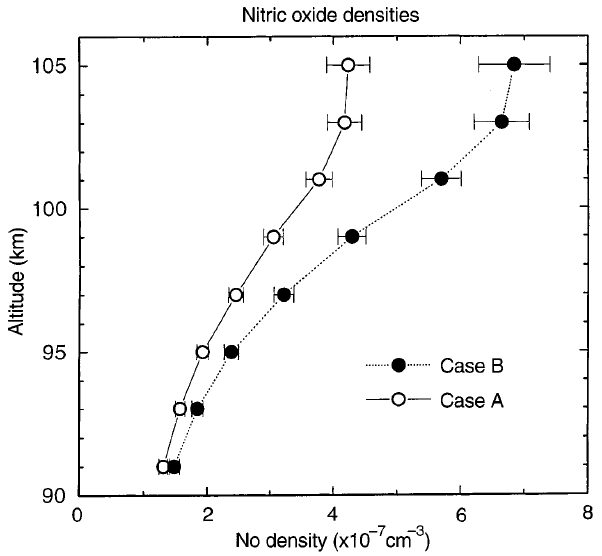
Fig. 3. The nitric oxide densities derived from the continuum emission rates of Fig. 2 and the atomic oxygen densities of Fig. 1. The solid line shows the densities obtained with the case A rate coe(cid:129)cients and the dashed line shows the densities obtained for case B